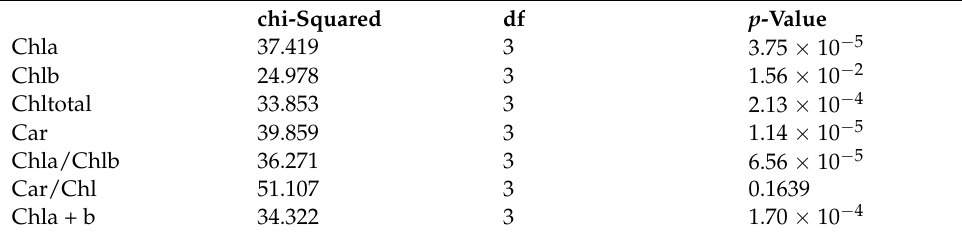
Table 6. Kruskal–Wallis rank-sum test of the seven leaf traits. Photosynthetic pigments: Chla (µg cm − 2 ) = chlorophyll a content; Chlb (µg cm − 2 ) = chlorophyll b content; Chl (µg cm − 2 ) = total chloro- phyll content; Car (µg cm − 2 ) = carotenoid content; Chla/Chlb = chlorophyll a:b ratio; Car/Chl = ca- rotenoid:total chlorophyll ratio; Chla + b = sum of chlorophyll a and b; significance ( p ≤ 0.05). chi-Squared